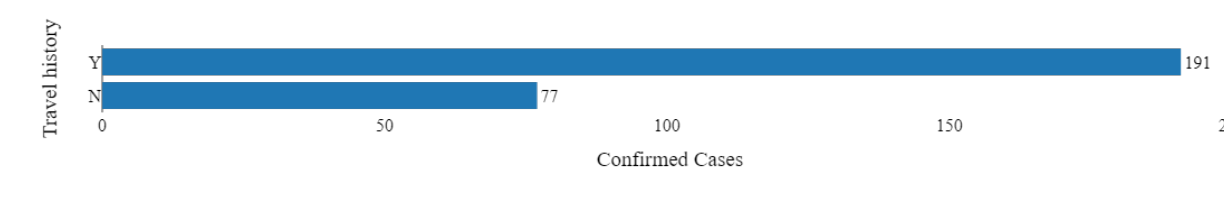
Figure 11. Distribution of confirmed cases with travel history.